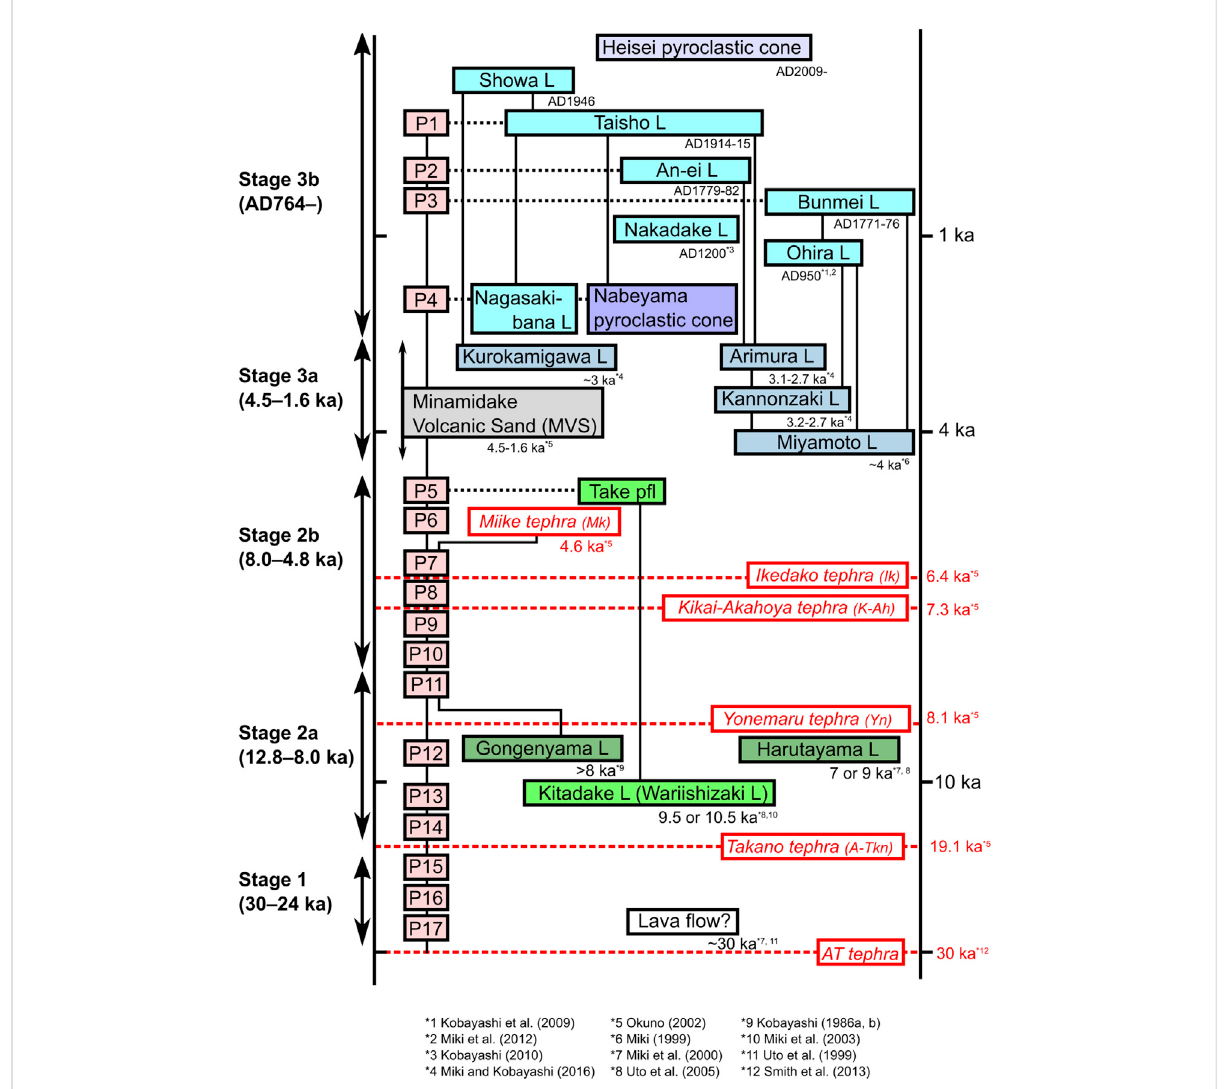
FIGURE 2 The sequence of theeruptiveproducts of Sakurajima volcano. Abbreviations of “ L ” represent “ lava. ” The solidcolorsofeach lava are identical to Figure 1B. Tephra deposits shown in red are the exotic ones interbedding within the Sakurajima tephra. Dotted black horizontal lines represent volcanic products produced by a single eruption with several phases. Solid black vertical lines indicate that the sequence relationships of the two products connected by the lines have been con fi